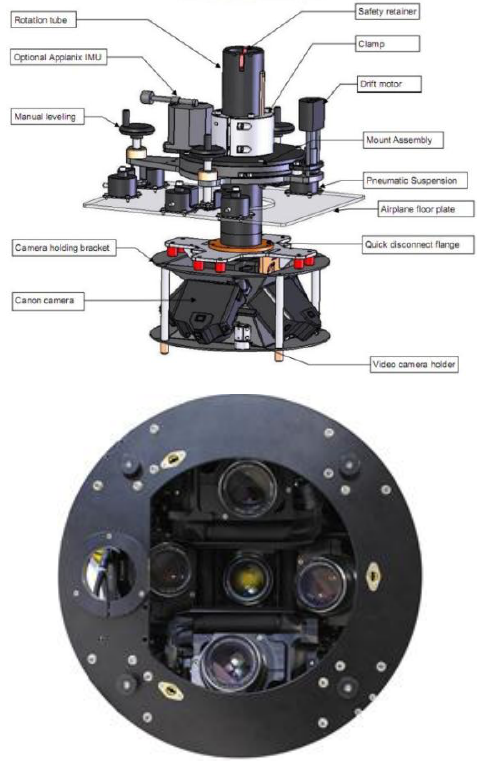
Figure 1. MIDAS Camera